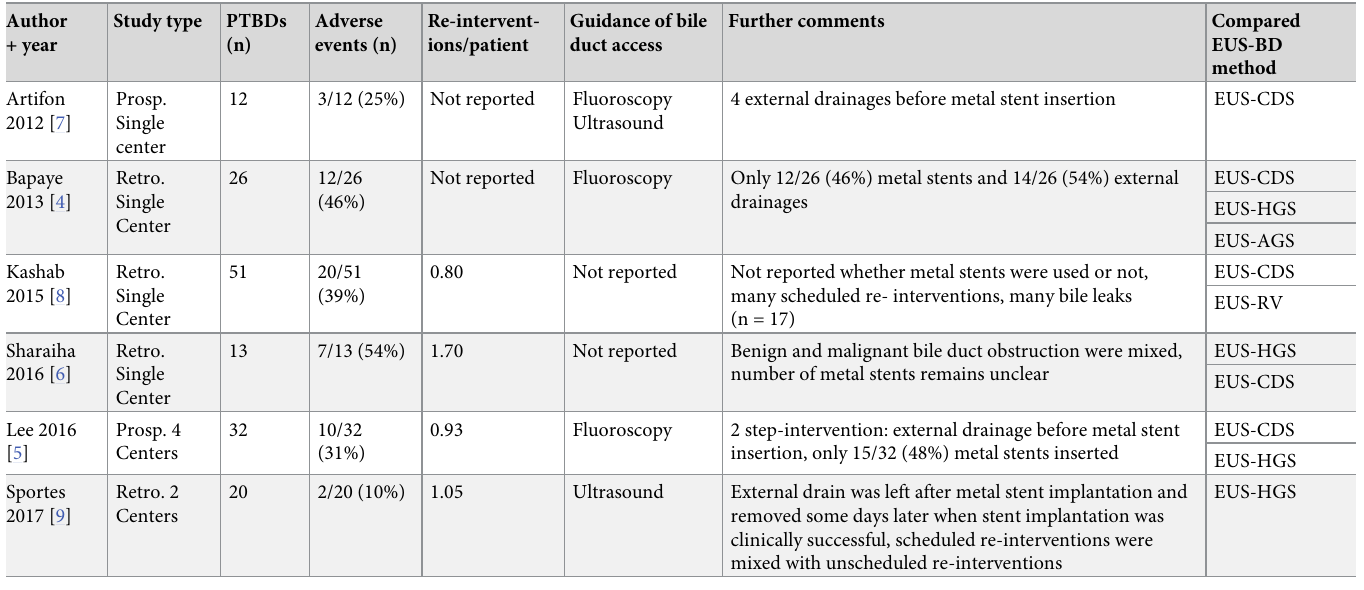
Table 1. Commented overview of the reported PTBD procedures in the published comparative studies on PTBD versus